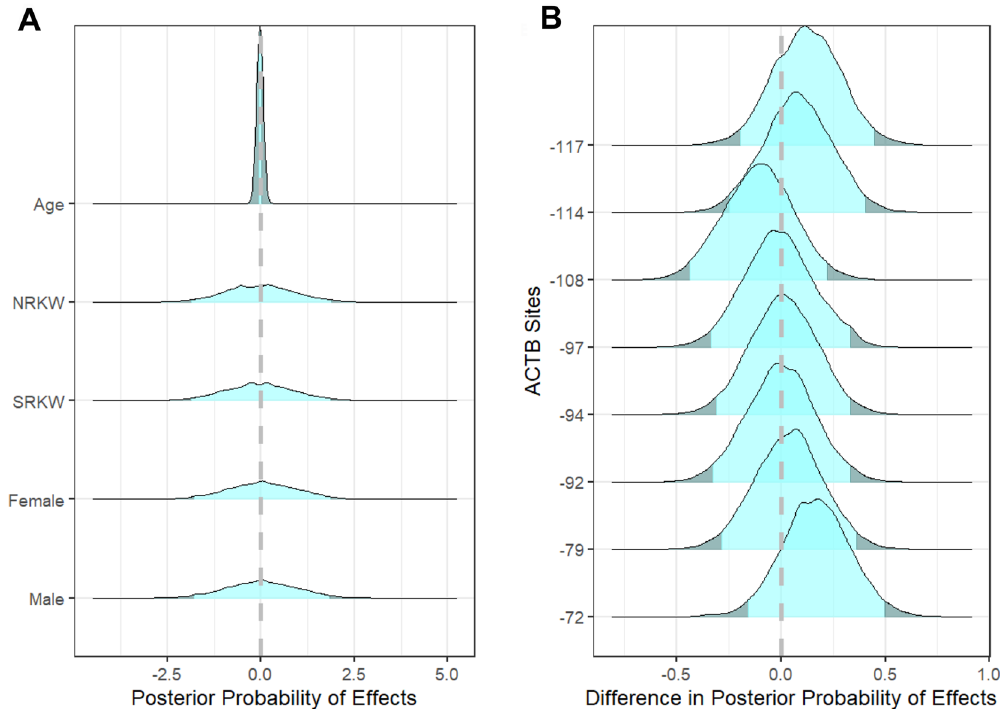
Figure 2. (A) The independent effects of age, population (Northern and Southern Resident killer whales: NRKW and SRKW) and sex on percent methylation of examined CpG sites showed little effect of total methylation patterns. (B) The control gene ACTB showed little to no difference in methylation patterns between Southern and Northern Residents. Y-axis is the number of base pairs prior to the transcriptional start site (TSS), hence the negative values. Positive X-values indicate hypermethylation in Southern Residents relative to Northern Residents and negative values indicate hypomethylation. The distribution falling outside the 95% highest density interval is indicated with the darker